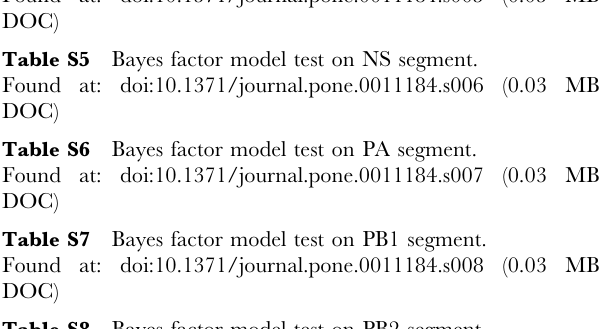
Table S5 Bayes factor model test on NS segment.